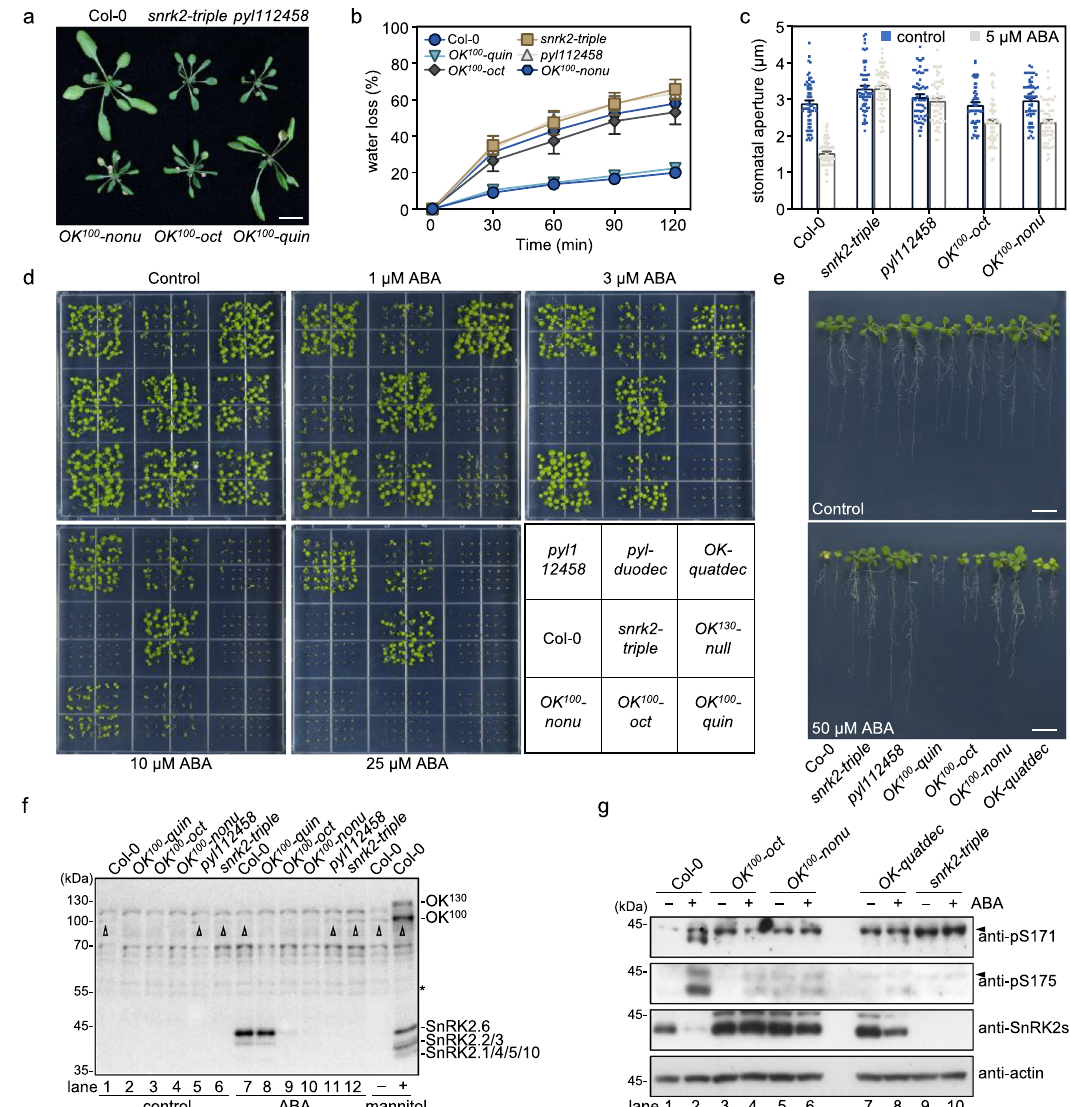
Fig. 4 B2 and B3 RAFs cooperate in ABA-induced SnRK2 activation. a Photographs of wild-type and mutant seedlings after 4 weeks of growth in the